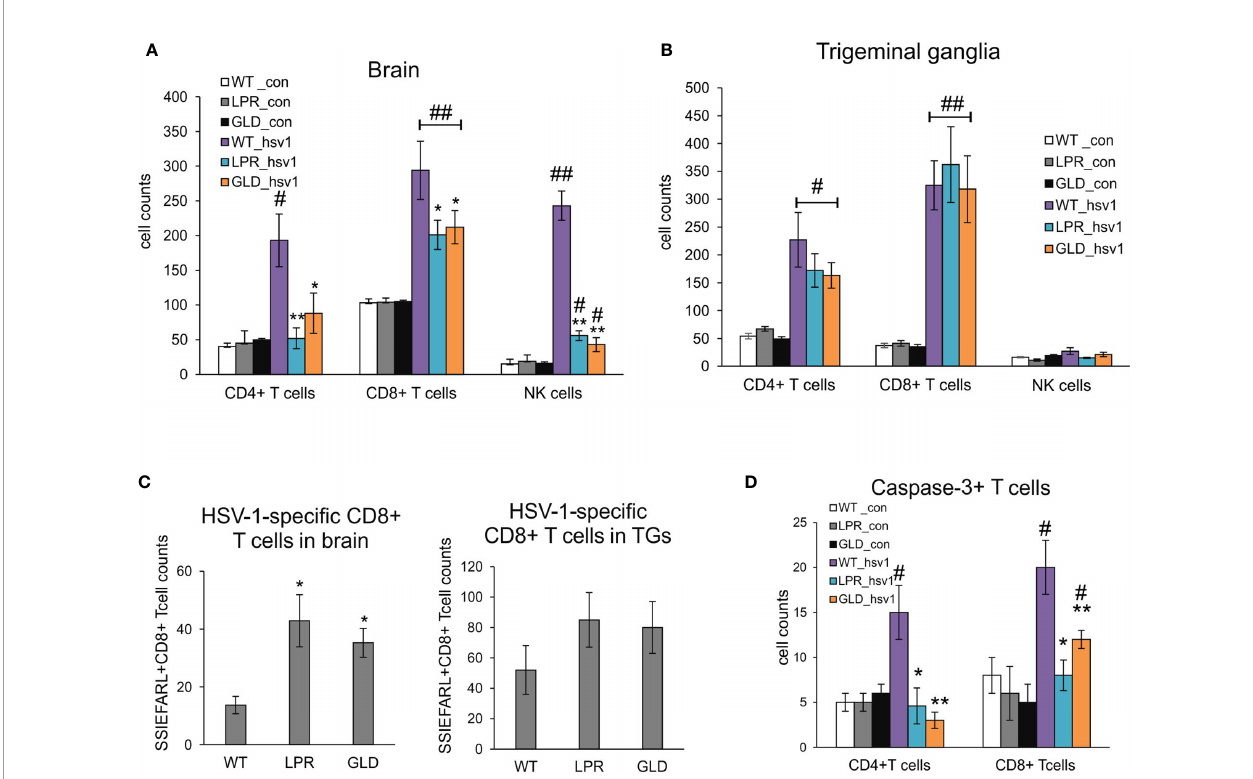
FIGURE 3 | Fas/FasL in fl uences in fi ltration of T cells and NK cells into the HSV-1 infected brains but not trigeminal ganglia. Cell counts for CD4+ T cells, CD8+ T cells and NK cells were measured by fl ow cytometry in brains (A) and trigeminal ganglia (B) of mice uninfected and infected with HSV-1 at 8 d p.i. Data were presented as mean ± SEM, N = 8. Data analysis was performed by comparing Fas-de fi cient (lpr) and FasL-de fi cient (gld) groups with wild-type (C57BL/6) mice. **p ≤ 0.001, *p ≤ 0.05. (C) HSV-1 speci fi c CD8+ T cells (SSIEFARL+) in brains and ganglia of wild-type, lpr and gld mice measured by fl ow cytometry. Data were presented as mean ± SEM, N = 8. Data analysis was performed by comparing lpr and gld groups with wild-type (C57BL/6) mice. P ≤ 0.05. (D) Numbers of T cells (CD4+ and CD8+) positive for active form of caspase-3 in brains of wild-type, lpr and gld mice at 8 dp.i. Data were presented as mean ± SEM, N = 8. Data analysis was performed by comparing lpr and gld groups with wild-type (C57BL/6) mice and between control and uninfected groups. **indicates P ≤ 0.001, while *P ≤ 0.05 compared to wild-type mice; # indicates P ≤ 0.001, ## indicates P < 0.05, in pairs control –